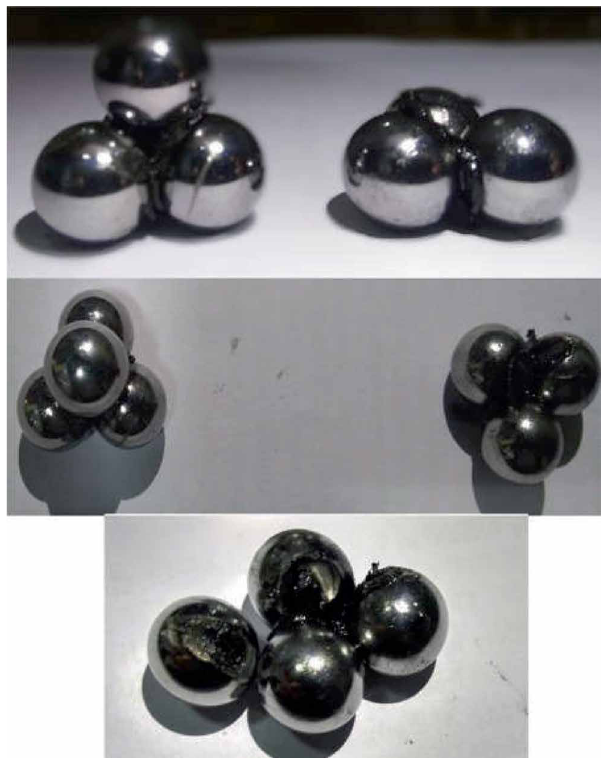
Figure 10: Steel balls after extreme pressure test at the seizure